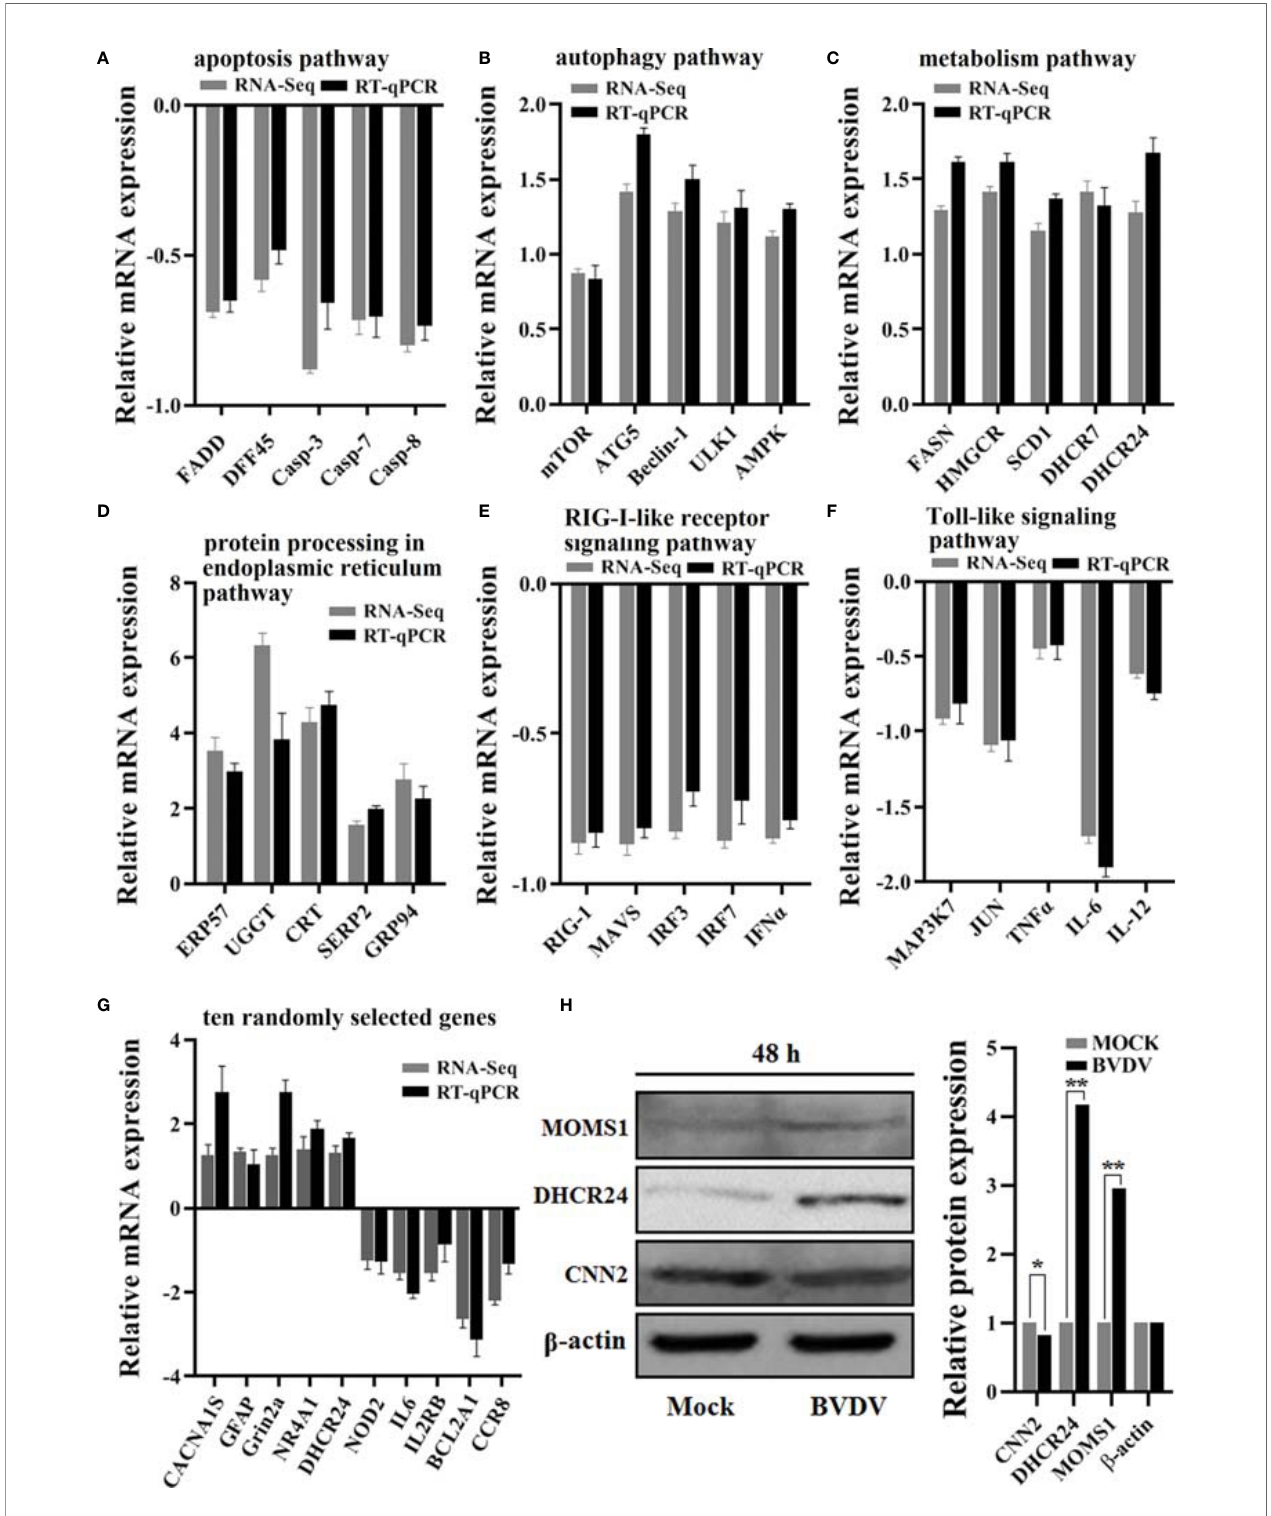
FIGURE 9 | Veri fi cation of the RNA-seq-based transcriptomics data and the iTRAQ-based proteomics data obtainedin this study. The DEGs from RNA-seq-based transcriptomics dataanalysis that primarily involvedin (A) theapoptosis pathway, (B) the autophagy pathway, (C) the metabolism pathway, (D) theproteinprocessing in endoplasmic reticulum pathway, (E) the RIG-I-like receptor signaling pathway, and (F) the Toll-likesignaling pathwaywereveri fi edusing RT-qPCR and (G) the 10 randomly selected genes. Additionally, (H) the protein expression levels of the DEPs DHCR24, MOMS1, andCNN2 were veri fi edusing westernblot. *P-value < 0.05; **P-value <